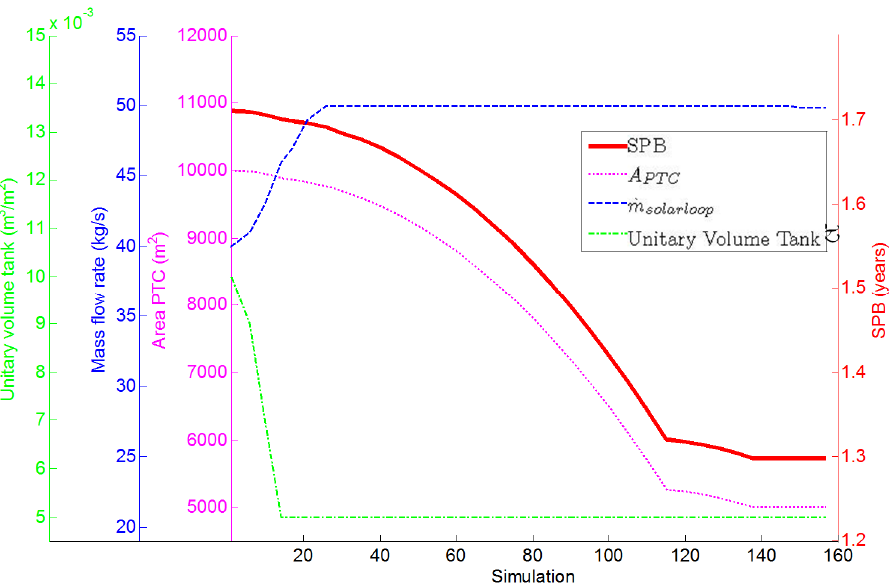
Figure 18. Optimization of the plant using the SPB as objective